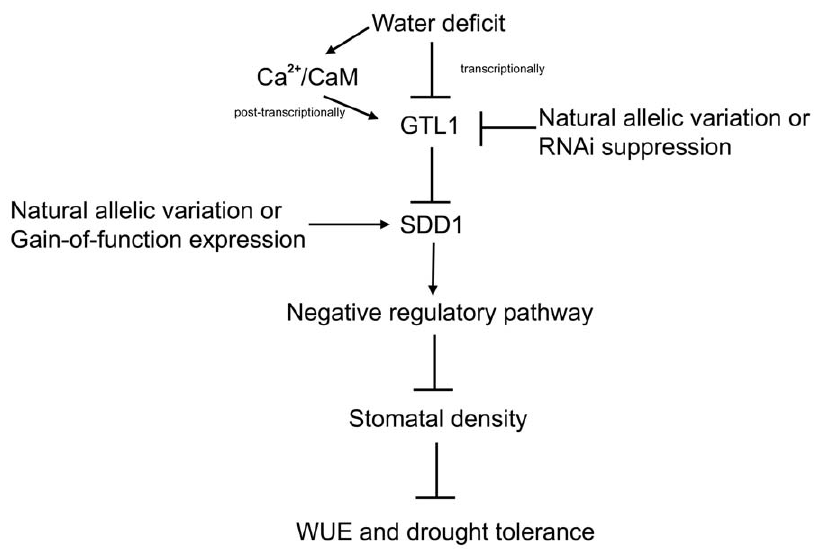
Figure 6. A model for GTL1 as a node for integration of the environment on stomatal development, WUE, and drought tolerance. GTL1 activity is negatively regulated by water deficit conditions in two ways. Transcriptionally, GTL1 is down-regulated under water deficit conditions. Post-translationally, GTL1 activity is repressed through Ca 2 + /CaM signaling induced by water deficit. Lower GTL1 activity will lead to increased stomatal density through reduced trans-repression of SDD1, a negative regulator of stomatal development. Therefore, GTL1 serves as a node to integrate environment signals into regulation of stomatal density, thus achieving higher WUE and drought tolerance. Allelic variation in poplar GTL1 and SDD1 may be used to identify poplar with higher WUE and no or negligible reductions in biomass. Alternatively, RNAi suppression or other biotechnological approaches can be used to generate commercial genotypes that have higher WUE without a reduction in biomass and are potentially more drought